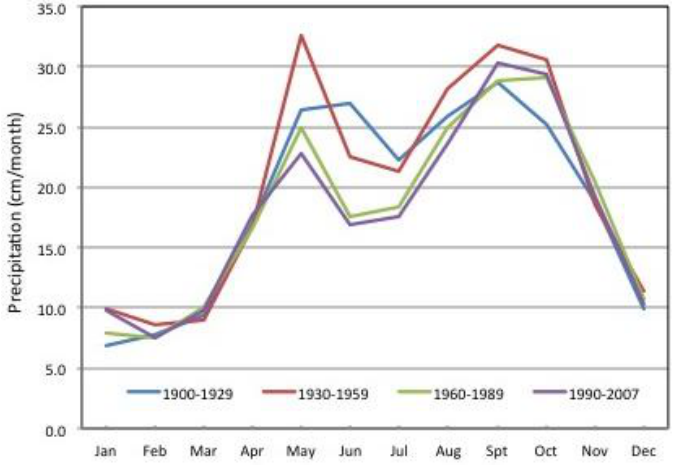
Figure 15. Wet forest annual cycle monthly precipitation by period.